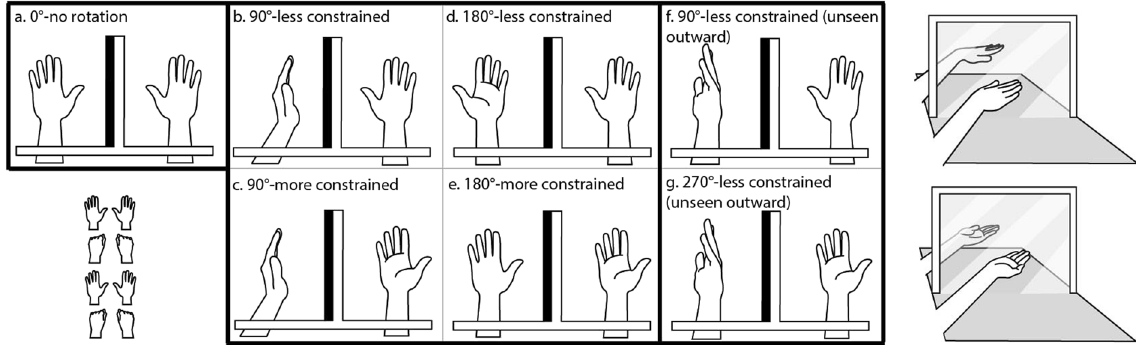
Figure 2. Top-down view of hand postures in Experiment 2 with the left hand behind the mirror ( a – g ). The mirror reflections of the hand are shown in the top and bottom right panel. An example sequence of hand movements is shown in the bottom left panel, in which participants opened and closed both hands synchronously. Each condition is named based on the amount of angular disparity defined as the difference (in degrees) between the proprioceptively-defined and visually-defined hand posture, and (within each angular disparity group) whether the rotation between the two hand postures is more or less biomechanically constrained. The “outward” posture in conditions f and g means palm facing away the body midline, reached by clockwise rotation of the left hand (and counter-clockwise rotation of the right hand) by 90° from the palm- down